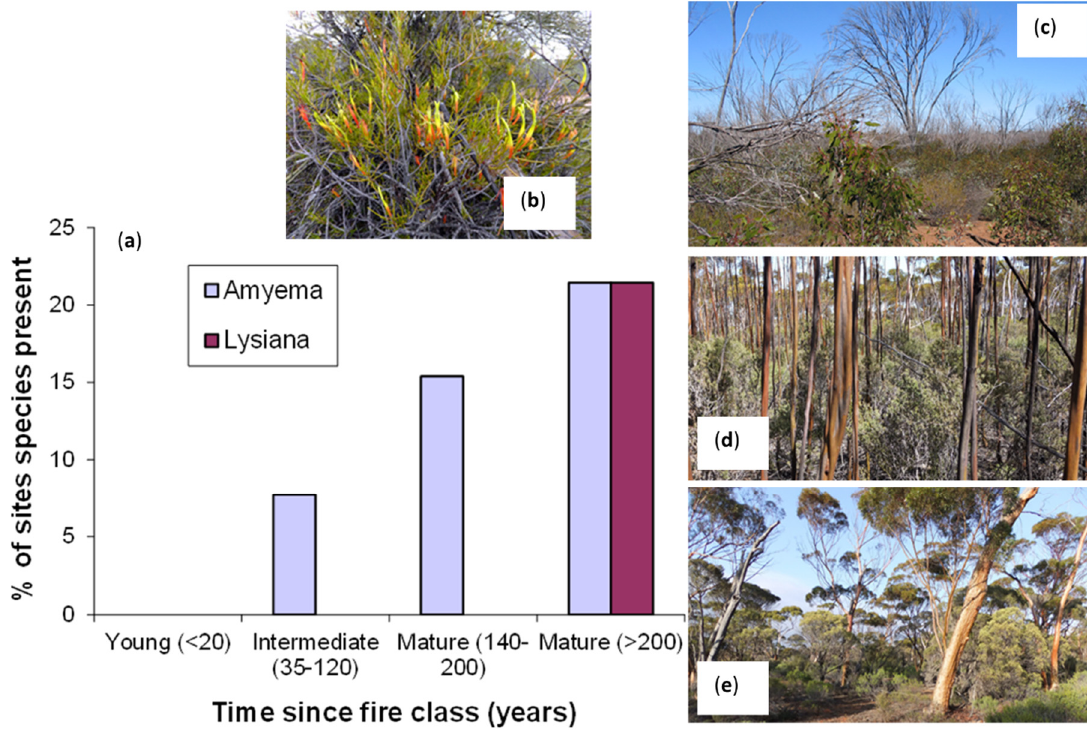
Figure 1. ( a ) Occurrence of two mistletoes unable to resprout or recruit from persistent seed banks after a fire in plots in time since fire chronosequence in obligate-seeder eucalypt woodlands. Plot time since fire follows Gosper and co-workers [7], using the conservative model 2 method; ( b ) Lysiana casuarinae on a host Exocarpos ; ( c – e ) obligate-seeder eucalypt woodland at ( c ) young ( < 20 years); ( d ) intermediate (35–120); and ( e ) mature ( > 200 years) stages of post-fire succession. Photos: Carl Gosper.